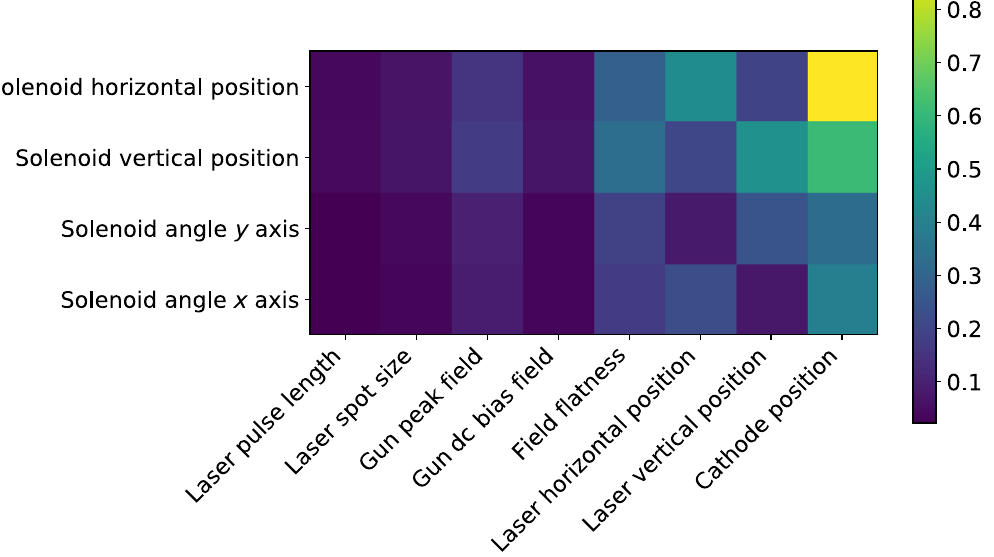
FIG. 9. Standard deviations of the Jacobian matrix of 100,000 state values and their chosen actions; A high value in the color scale means the standard deviation of the partial derivatives is high. It shows that the derivatives of the solenoid position have high fluctuations both vertically and horizontally with respect to the cathode